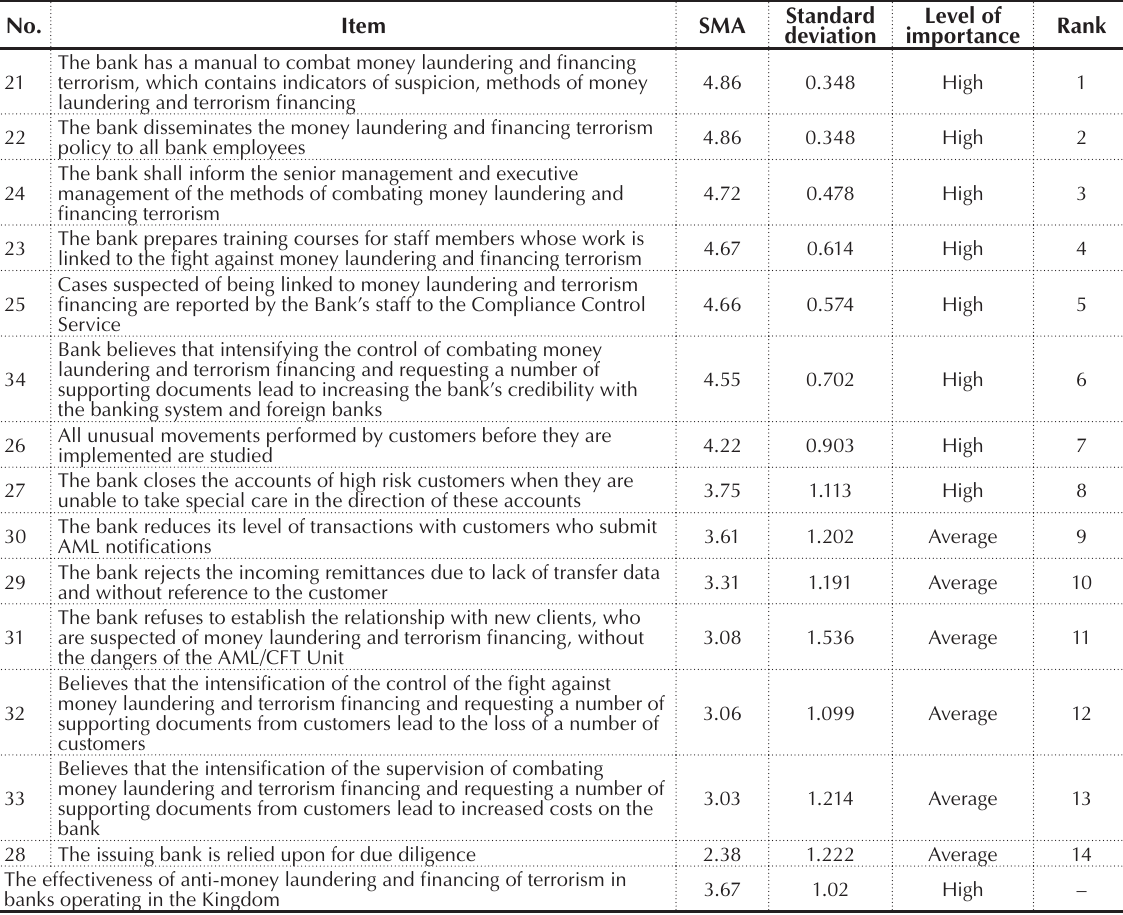
Table 6. (cid:47)(cid:374)(cid:282)(cid:349)(cid:272)(cid:258)(cid:410)(cid:381)(cid:396)(cid:400)(cid:3)(cid:396)(cid:286)(cid:367)(cid:258)(cid:410)(cid:286)(cid:282)(cid:3)(cid:410)(cid:381)(cid:3)(cid:410)(cid:346)(cid:286)(cid:3)(cid:373)(cid:286)(cid:258)(cid:400)(cid:437)(cid:396)(cid:286)(cid:373)(cid:286)(cid:374)(cid:410)(cid:3)(cid:381)(cid:296)(cid:3)(cid:410)(cid:346)(cid:286)(cid:3)(cid:286)(cid:299)(cid:286)(cid:272)(cid:415)(cid:448)(cid:286)(cid:374)(cid:286)(cid:400)(cid:400)(cid:3)(cid:381)(cid:296)(cid:3)(cid:410)(cid:346)(cid:286)(cid:3)(cid:302)(cid:336)(cid:346)(cid:410)(cid:3)(cid:258)(cid:336)(cid:258)(cid:349)(cid:374)(cid:400)(cid:410)(cid:3)(cid:373)(cid:381)(cid:374)(cid:286)(cid:455)(cid:3)